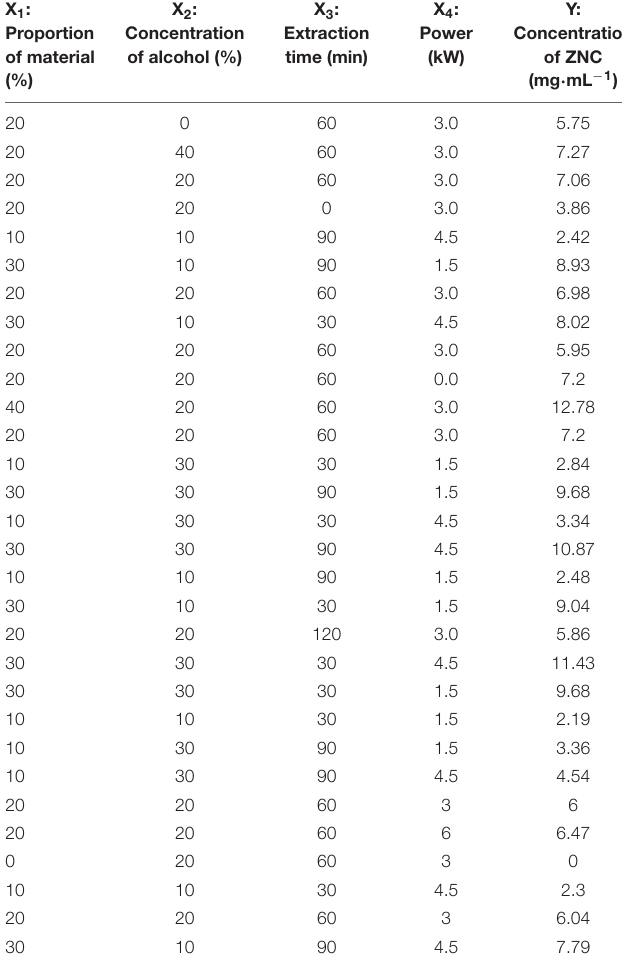
TABLE 1 | Design and result of central composite design